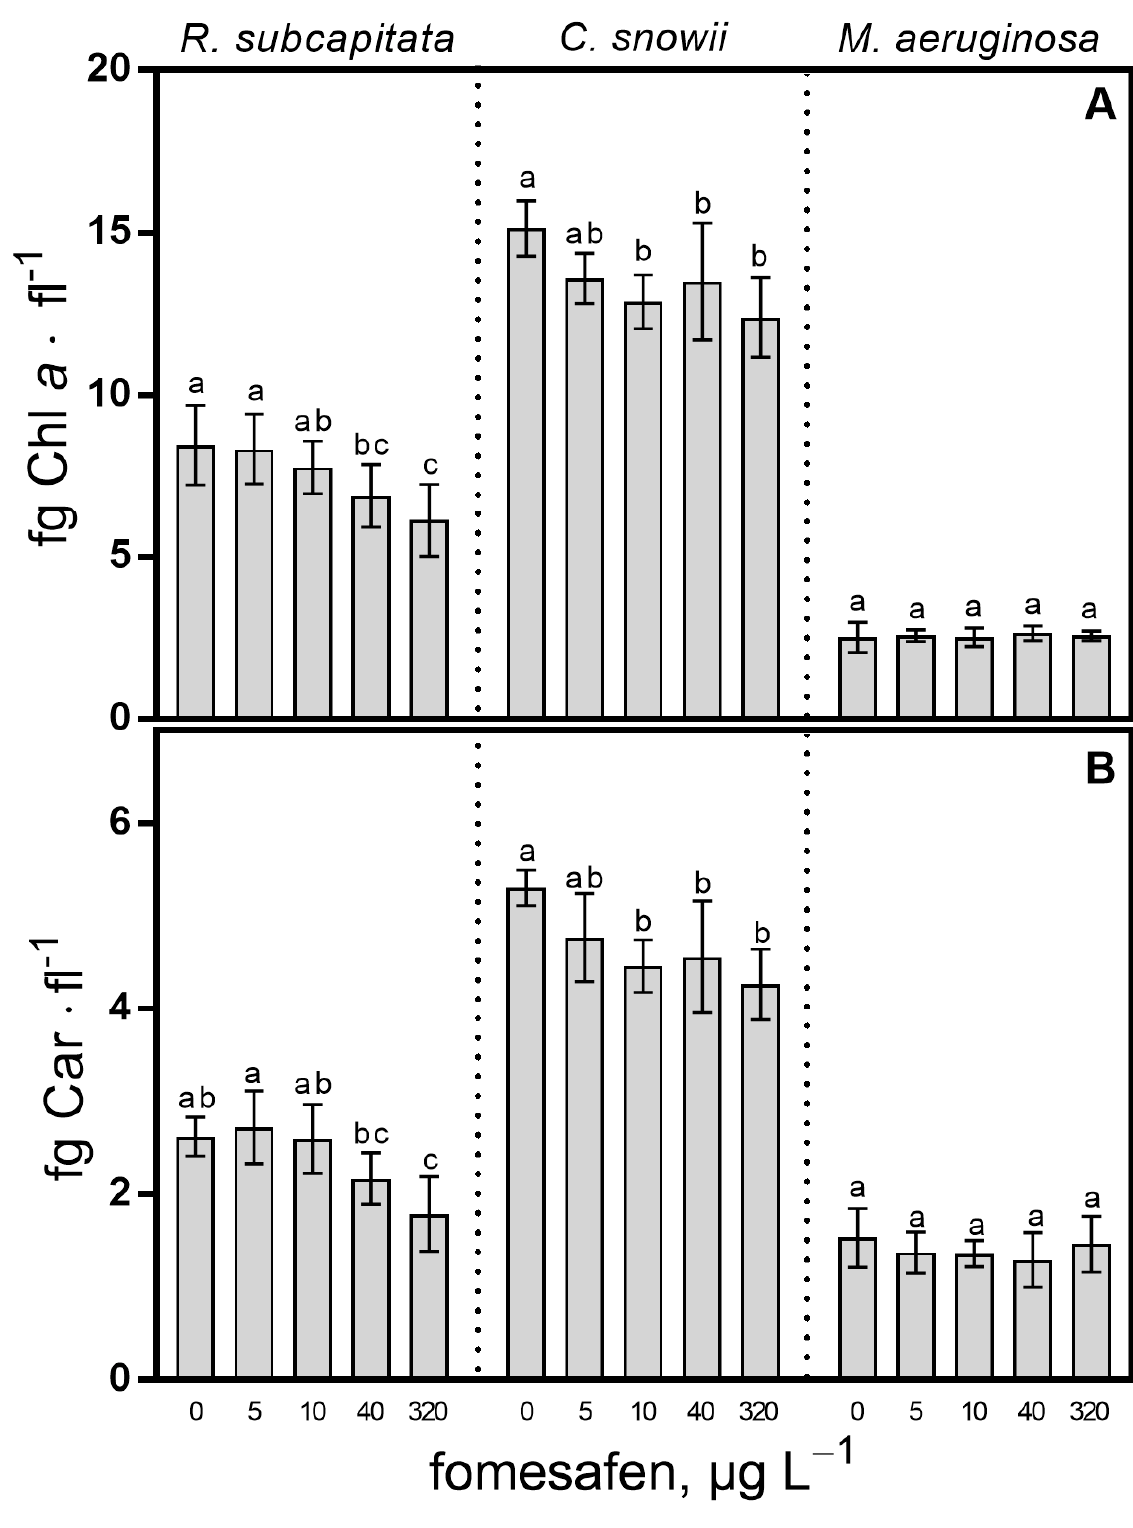
Figure 5. ( A ) Chl a and ( B ) Car content per cell and normalized to biovolume for R. subcapitata , C. snowii and M. aeruginosa after 72 h exposure to five concentrations of fomesafen-based herbicide (Reflex ® ; 0, 5, 10, 40 and 320 µ g · L − 1 fomesafen a.i.). Bars indicate the means ± standard deviation of nine replicates. Means followed by the same letter are not significantly different by the Tukey–Kramer HSD test or the Kruskal–Wallis test on ranked means.